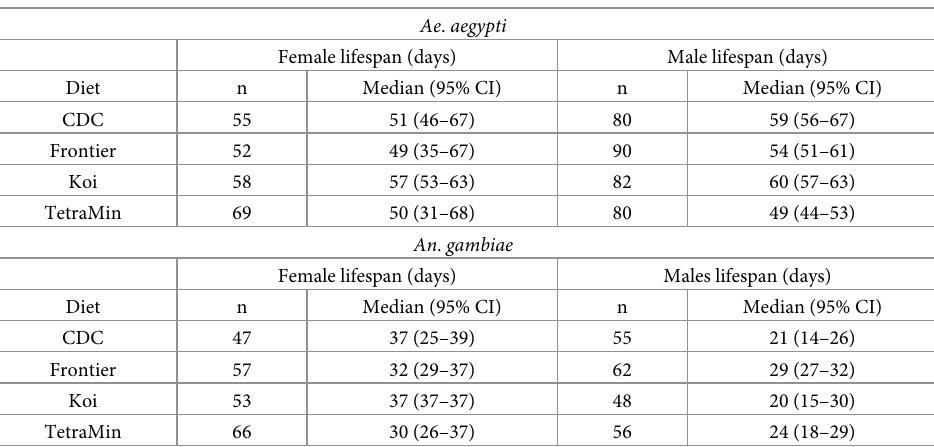
Table 5. Adult longevity.